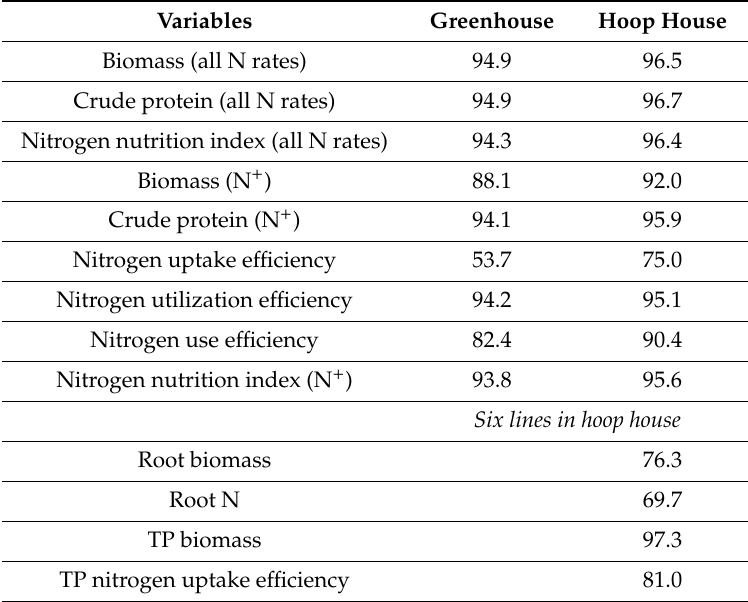
Table 2. R 2 values (%) of the split-plot in CRD statistical model for variables of all wheat lines evaluated in greenhouse and hoop house for biomass, crude protein, nitrogen nutrition index, nitrogen uptake e ffi ciency, nitrogen utilization e ffi ciency, and nitrogen use e ffi ciency. R 2 values (%) of the split-plot in CRD statistical model for root-related traits of selected six wheat lines evaluated in the hoop